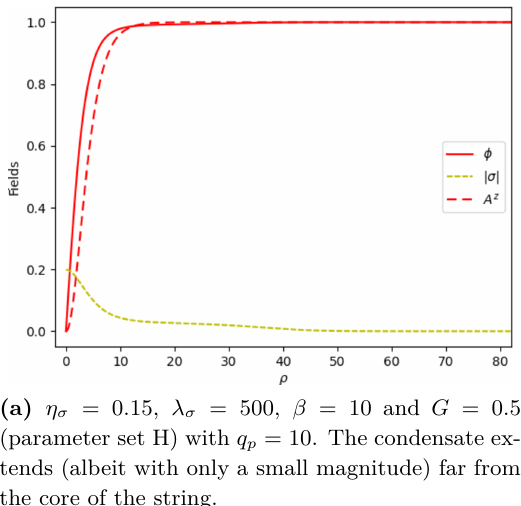
Figure 2 . Straight string profiles on the higher charge branch. These plots make the qualitative dif- ferences clear between parameter sets with β < 1